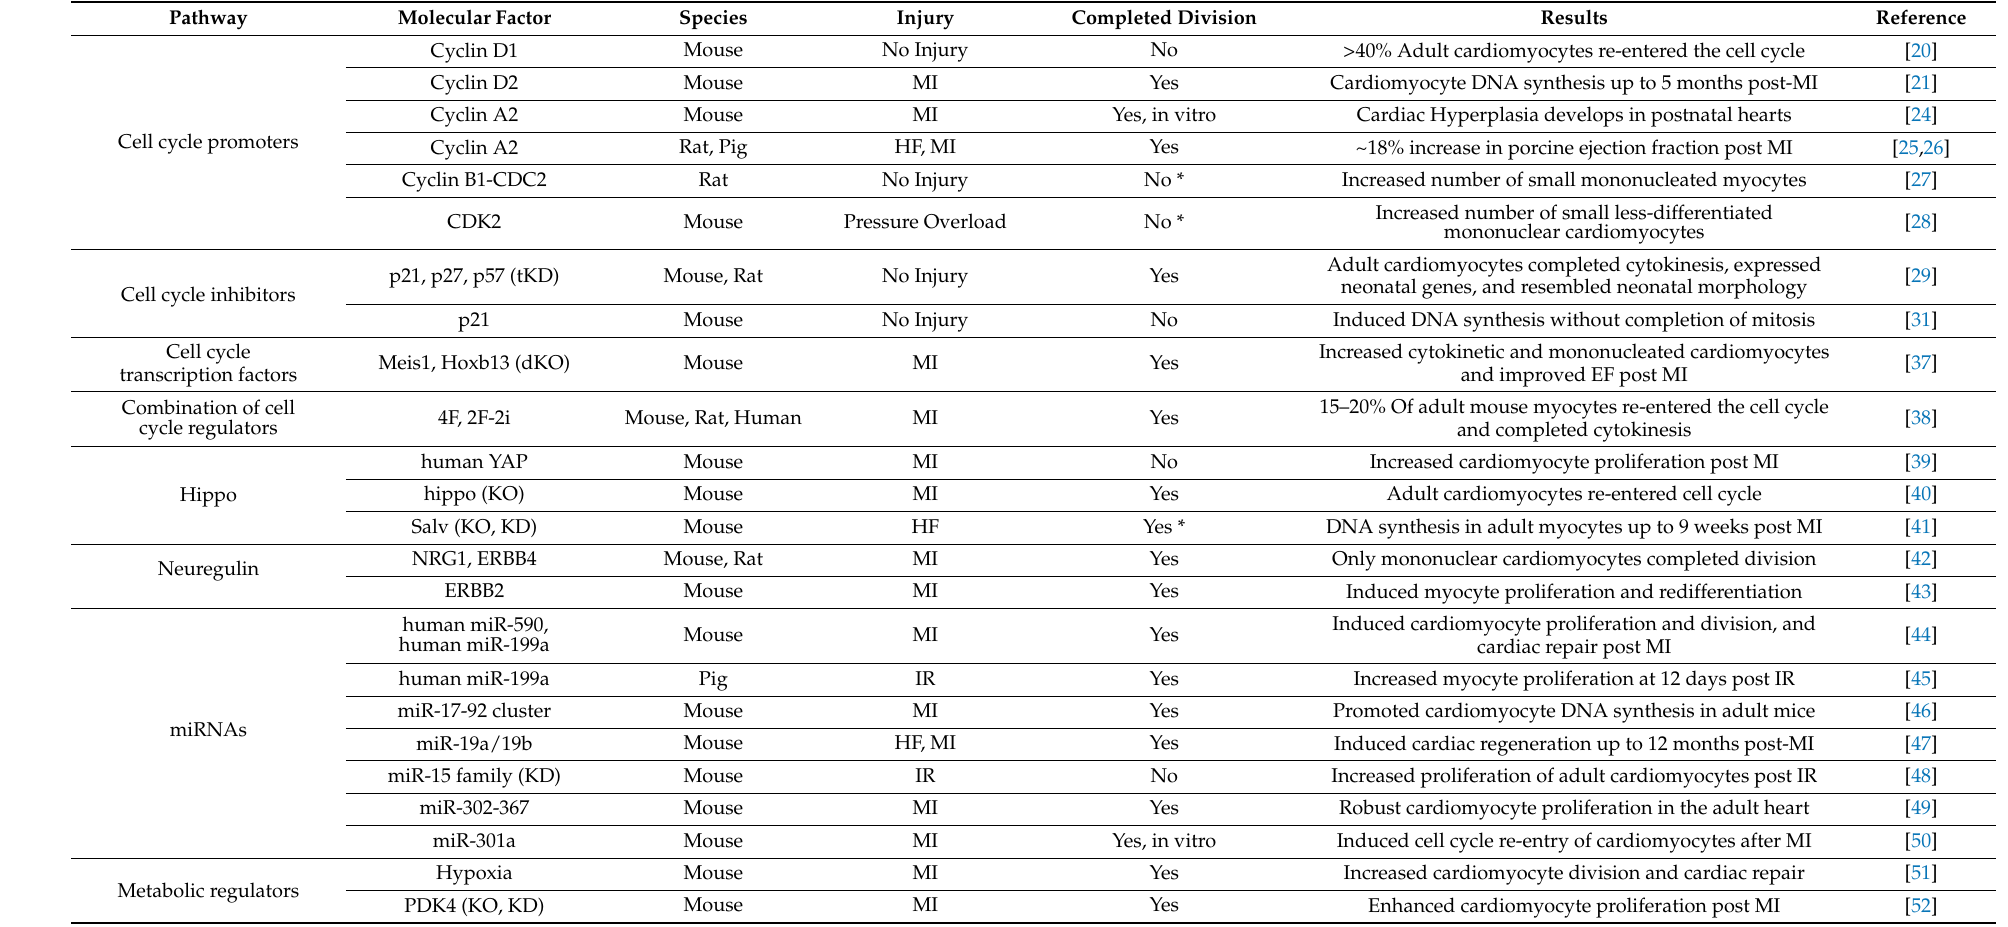
Table 1. Therapeutic stimulation of endogenous cardiomyocyte proliferation and cardiac